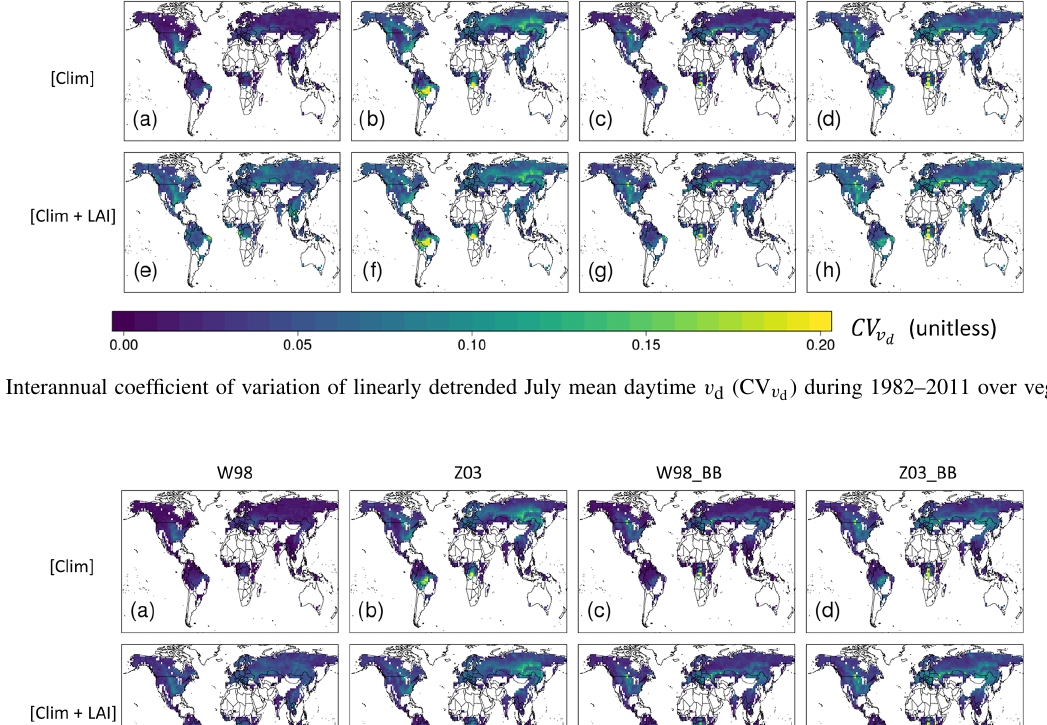
) during 1982–2011 over vegetated 3